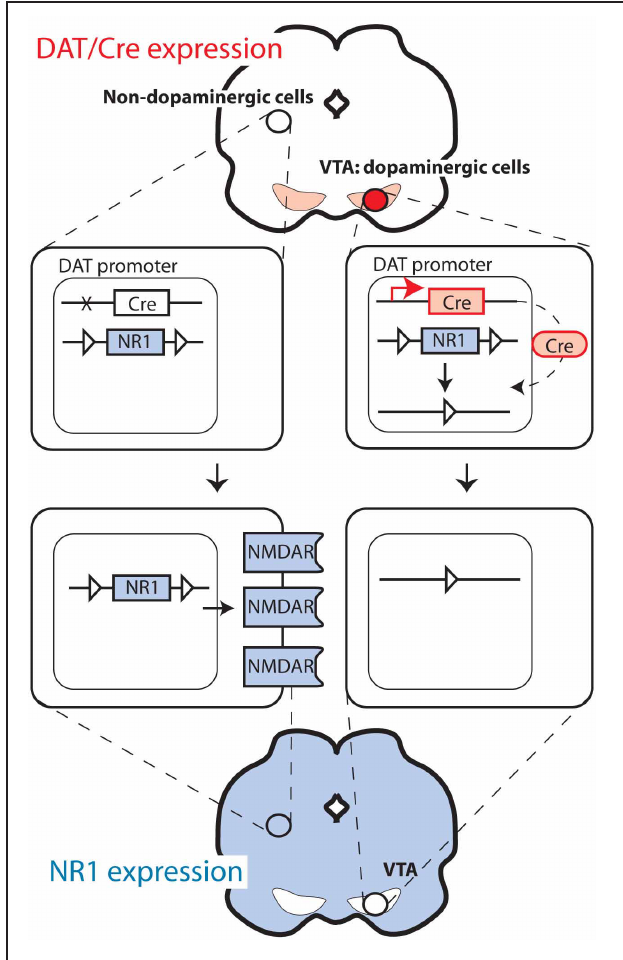
FIGURE 2 | Deletion of NMDA receptors selectively in dopaminergic